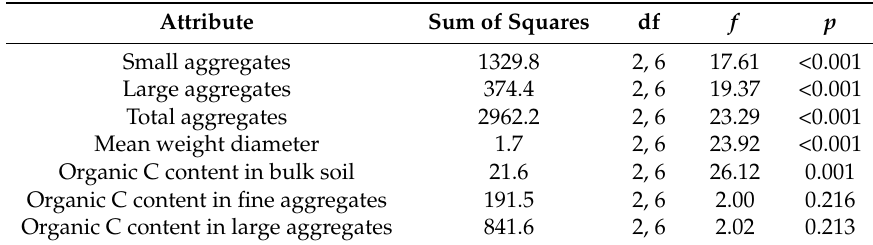
Table 2. The effects of stand age on small, large, and total aggregates, mean weight diameter, soil organic carbon in bulk soil, and organic carbon content in fine and large aggregates ( n = 3).